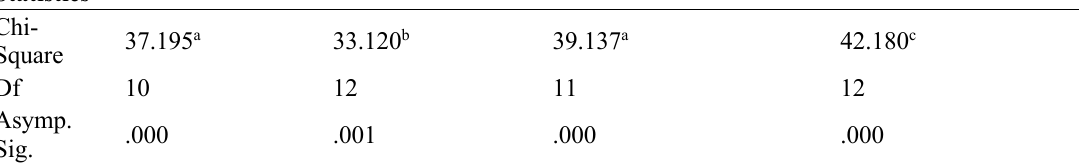
Table 12: Chi square Test